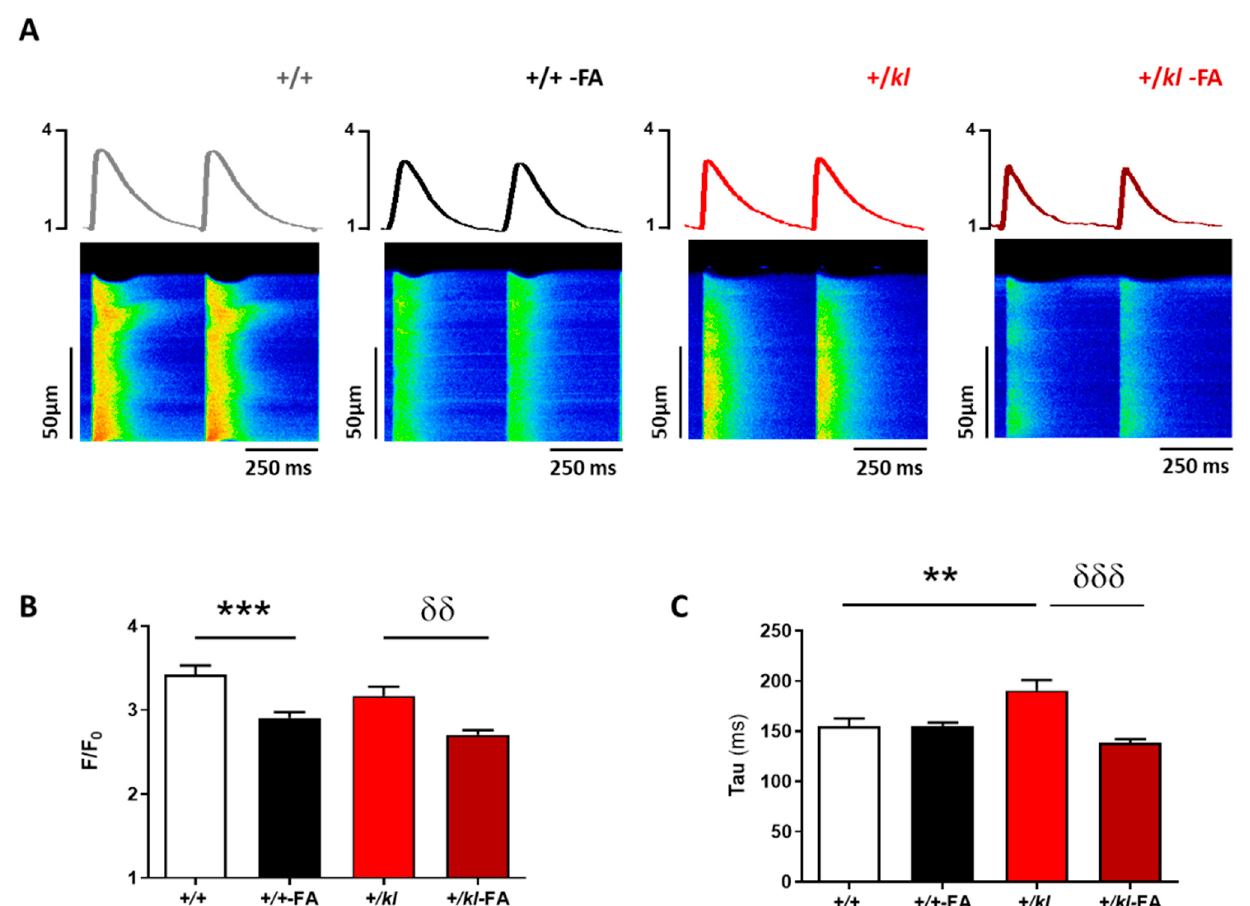
Figure 2. Partial klotho deficiency aggravates systolic Ca 2+ release from sarcoplasmic reticulum (SR) after AKI. ( A ) Fluorescence profiles (upper panel) of the representative line-scan confocal images of Ca 2+ transients (bottom panel). ( B ) Mean peak fluorescence of Ca 2+ transients (F/F 0 ). ( C ) Decay time constant, Tau (ms) of cardiomyocytes isolated from +/+ (n = 49 cells, N = 5 mice), +/+-FA (n = 81 cells, N = 4 mice), +/ kl (n = 47 cells, N = 5 mice) and +/ kl -FA animals (n = 66 cells, N = 3 mice). Data are expressed as mean ± SEM. ** p < 0.01, *** p < 0.001 vs. +/+, δδ p < 0.01, δδδ p < 0.001 vs. +/ kl .